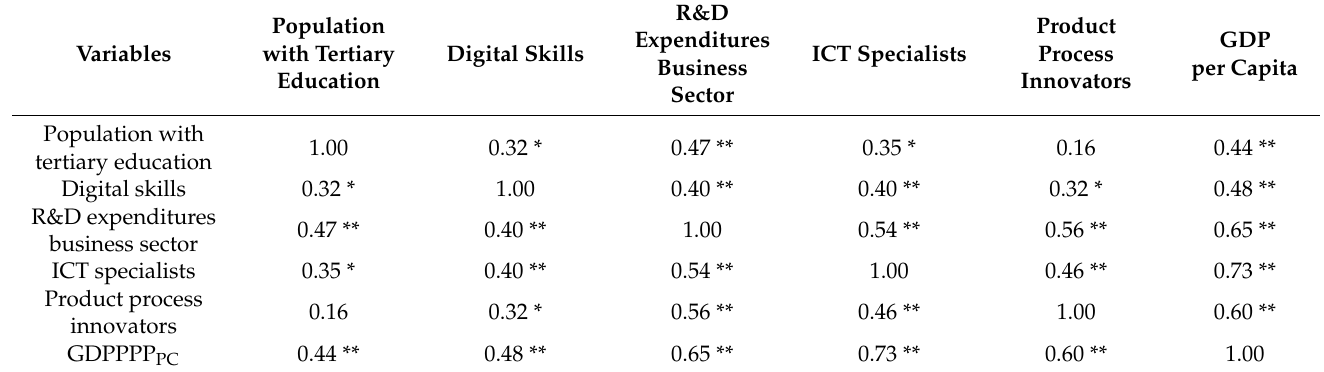
Table 9. Correlation coefficients.